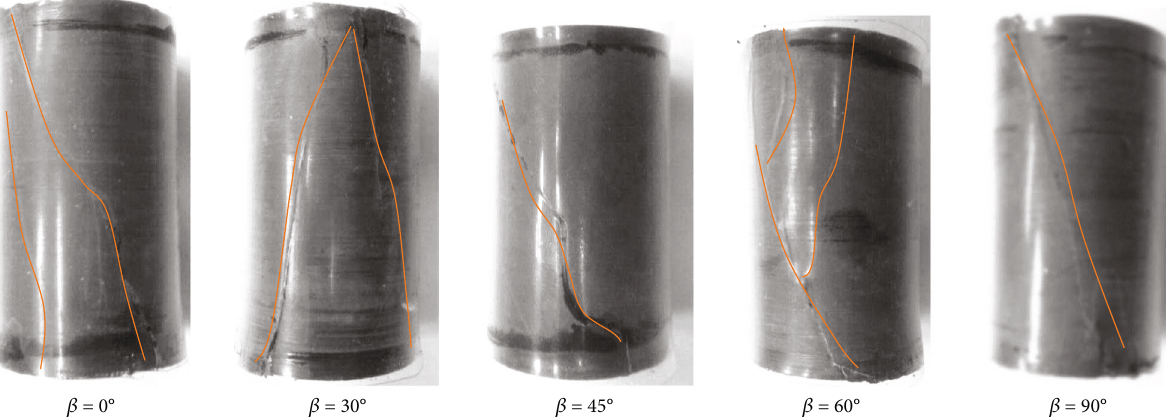
Figure 5: Failure modes of cores after